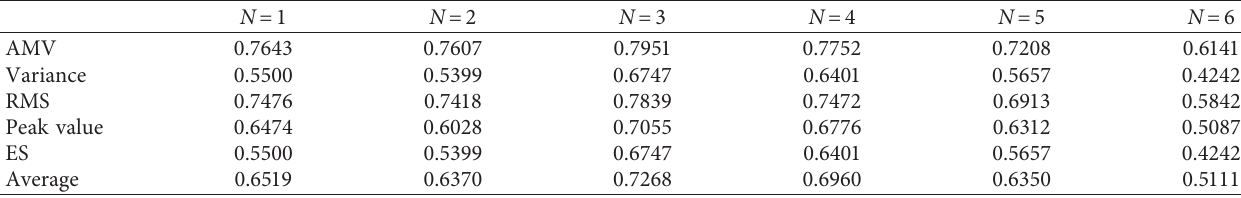
Figure 10: Diagram of trend values for different characteristic parameters decomposed by different wavelet functions. Table 3: Table of fusion indicator values for decomposing characteristic parameters of different decomposition layers.